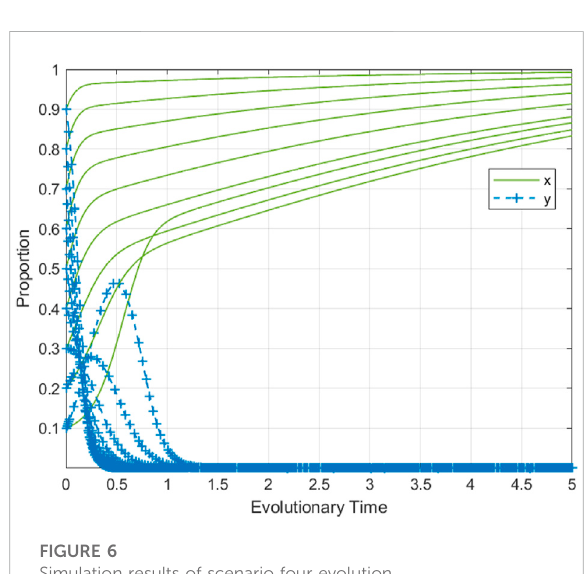
FIGURE 6 Simulation results of scenario four evolution.